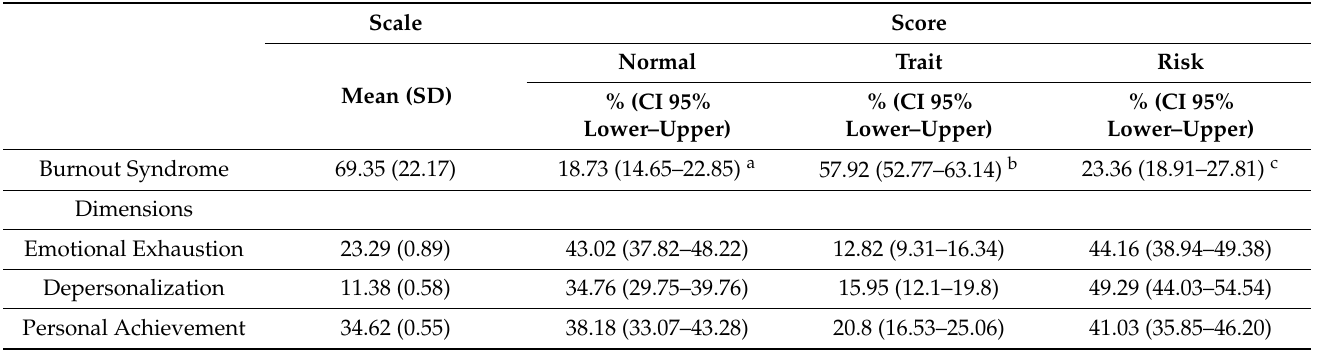
Table 3. Prevalence of Burnout Syndrome and dimensionality in police officers in